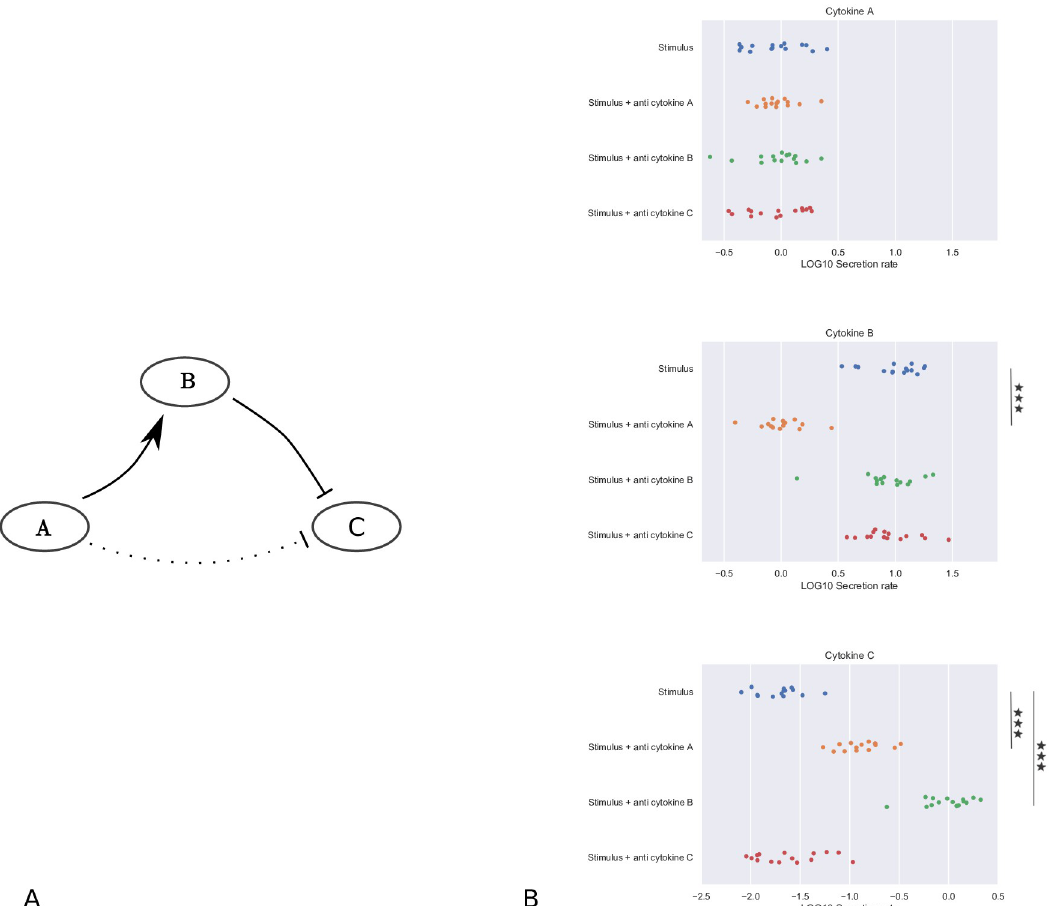
Fig 1. Example network motif and corresponding synthetic dataset. A: Addition of cytokine A up-regulates cytokine B secretion, whilst an increased concentration of cytokine B down-regulates cytokine C secretion. An increase in cytokine A concentration does not directly regulate cytokine C secretion (dotted edge), but only indirectly, via its effect on cytokine B secretion. B: Example synthetic dataset corresponding to the network motif shown in A. The dataset contains log-normally distributed synthetic cytokine secretion data from 15 ‘donors’ at a known moment in time, under the control condition (i.e. stimulus only, in blue), and in the presence of inhibitors of the cytokines of interest. For each of the four experimental conditions, cytokine secretion data for each of the three cytokines A, B and C is available. Full details on the construction of this dataset can be found in Section “Validation”. Using a two sample t-test, we test the hypothesis that the presence of inhibitor induces a change relative to the control: $$$ p � 0.001, false discovery rate (fdr)